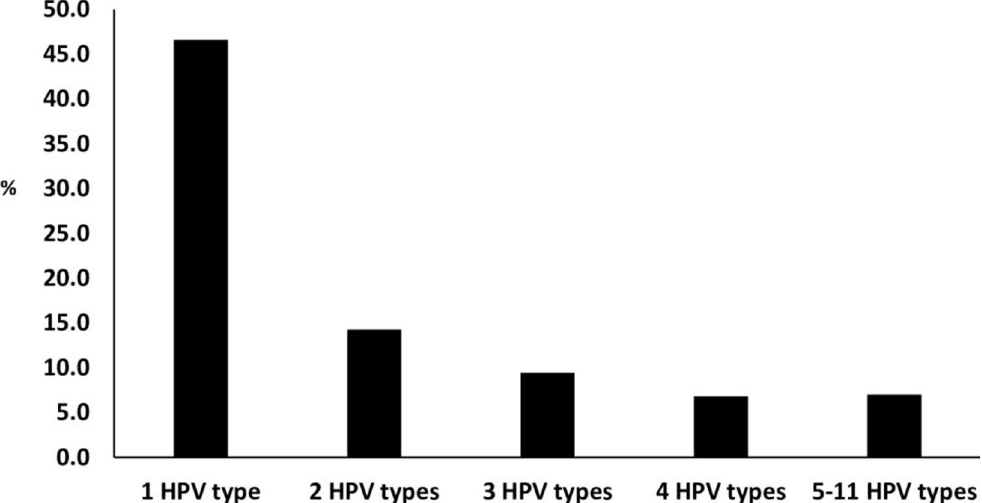
Fig 1. Human papillomavirus infection among women referred to Nelson Mandela Academic Hospital Gynaecology department, Eastern Cape